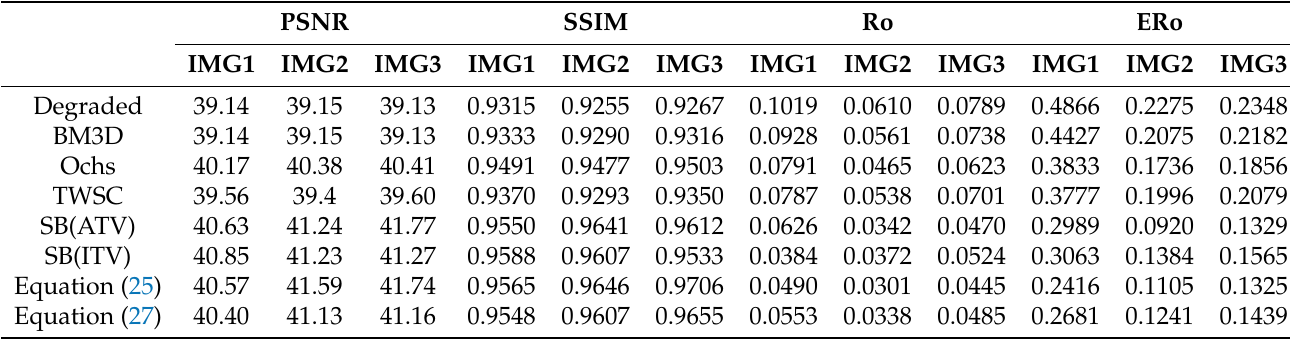
Table 5. Thermal image denoising using synthesized images with the conventional algorithms. Performances of each algorithm have been measured by four image assessments: PSNR, SSIM, Ro, and ERo.